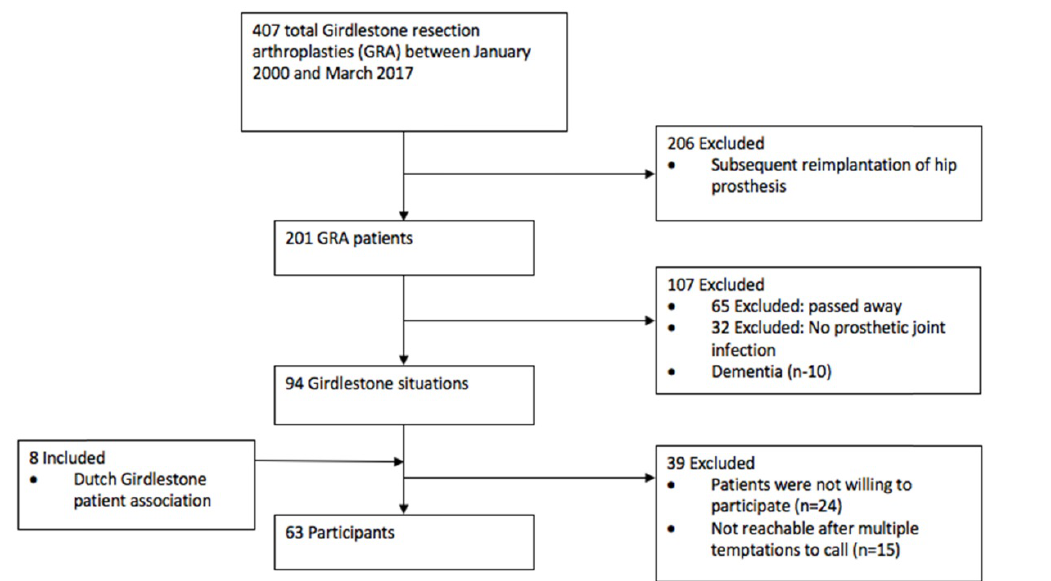
Figure 1. Flowchart showing inclusion/exclusion of the